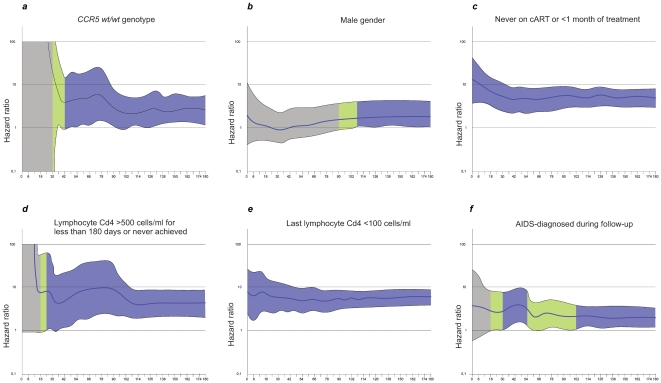
Hazard ratio changes during observation period.For calculation multivariate Cox regression adjusted for the six selected factors was used. Upper and lower confidence intervals are indicated as the external limits in the plot. For the values of borderline significance (p = 0.1–0.50) the field is marked in green while values of statistical significance (P<0.05) are marked in blue. a-CCR5 genotype, b- gender, c-antiretroviral treatment history, d- CD4 count >500 cells/µl maintained for at least half a year, e-the most recent CD4 count of 100 cells/µl, f- AIDS diagnosis.